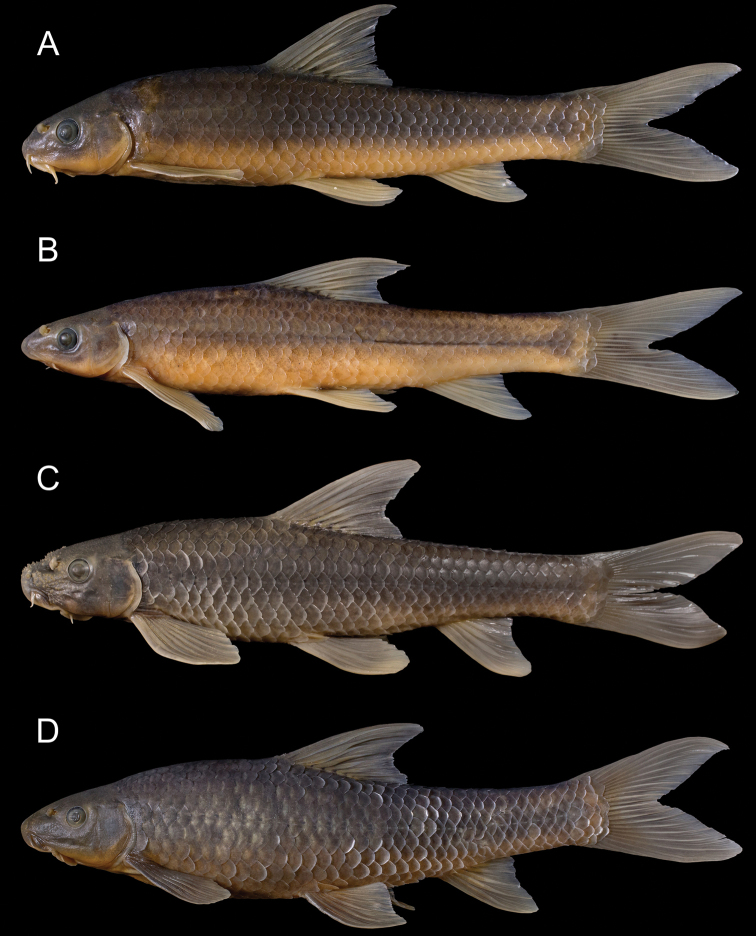
General appearance and morphological variability of Garra
makiensis from the Awash River. ANMW 99485, female, 85.8 mm SL, Adayitu (S13), BNMW 99485, female, 82.2 mm SL, Adayitu (S13), CNMW 99491, male, 106.1 mm SL, Dubti (S14), DNMW 99504, female, 147.9 mm SL, Jara River (T3).